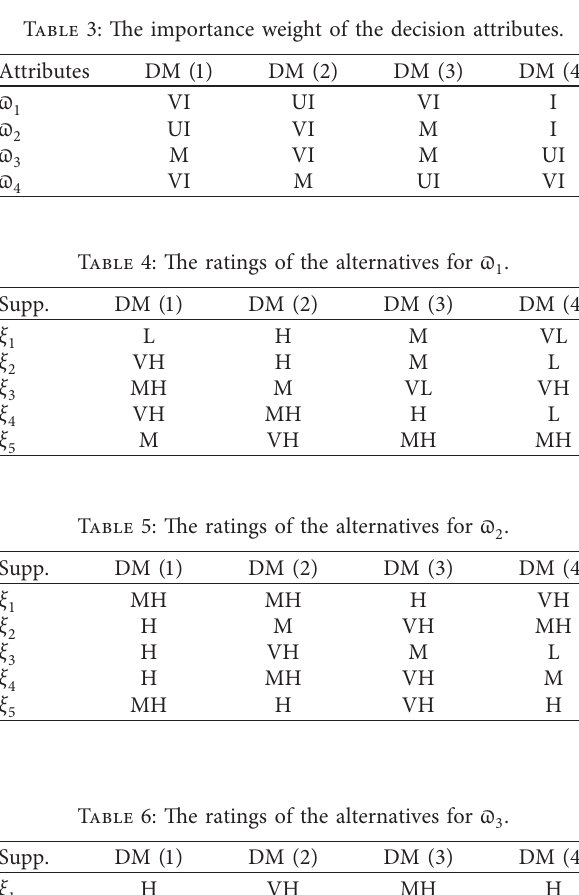
Table 7: The ratings of the alternatives for ϖ